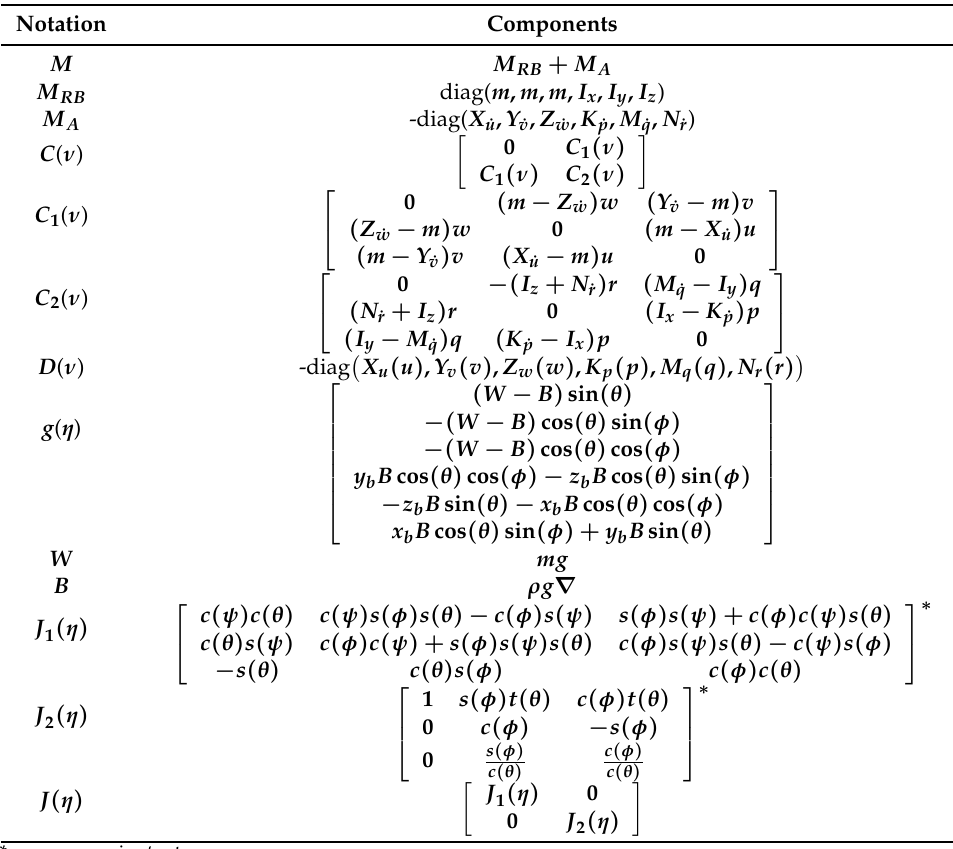
Figure 5. BlueROV2 with frame-definitions. Table 3. Variables and their